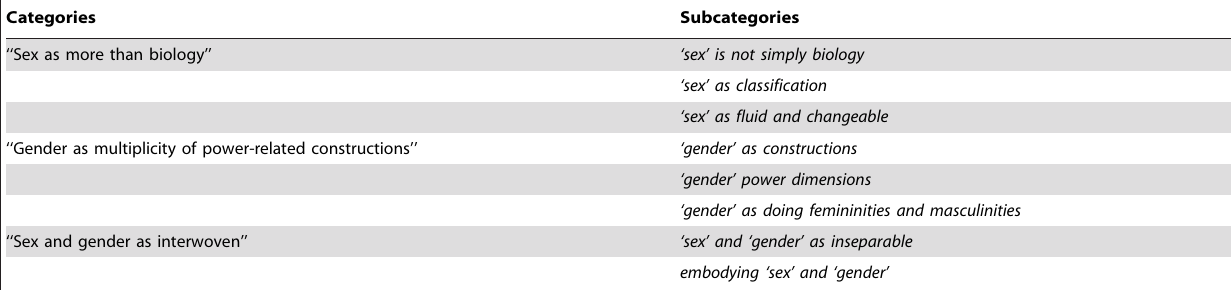
Table 1. Identified categories and